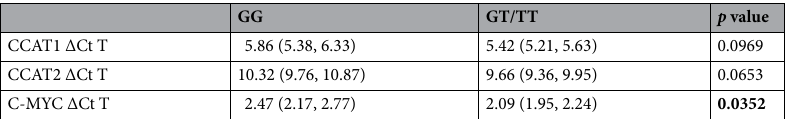
Table 2. Expression levels in tumours of patients with GG compared to those with GT/TT genotypes at rs6983267. Bold is significant ( p < 0.05)